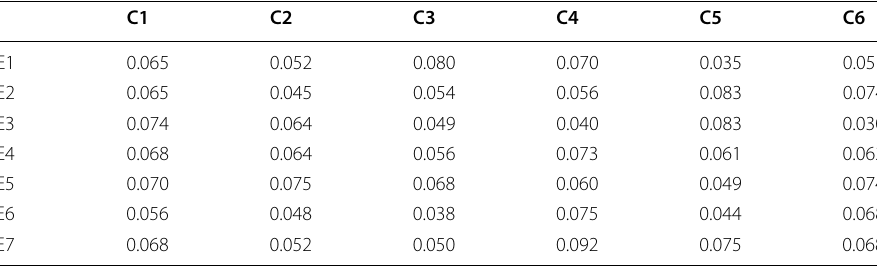
Table 22 Weighted matrix